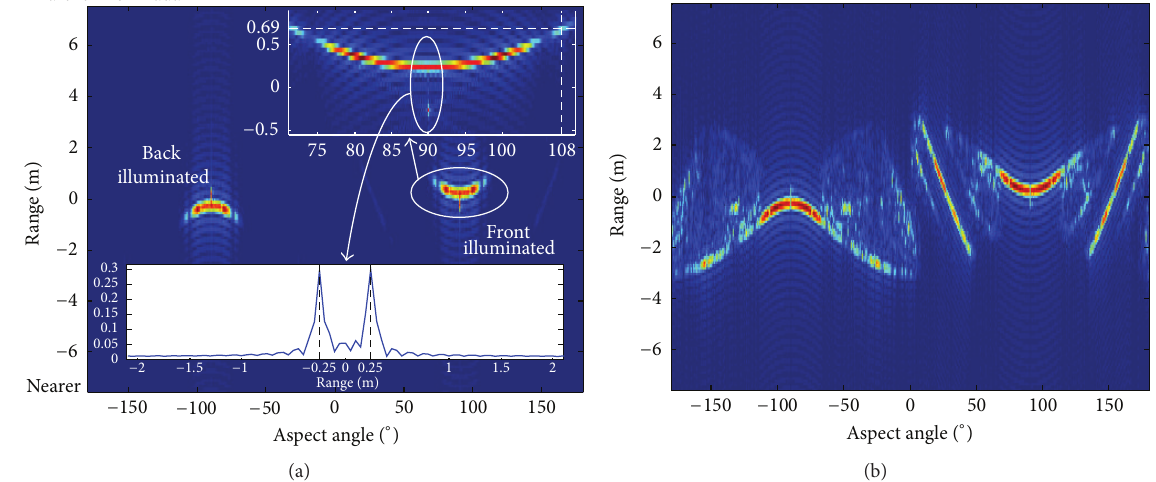
Figure 6: HRRP sequences of the PRA with (a) original and (b) normalized amplitude. GRECO data are used.